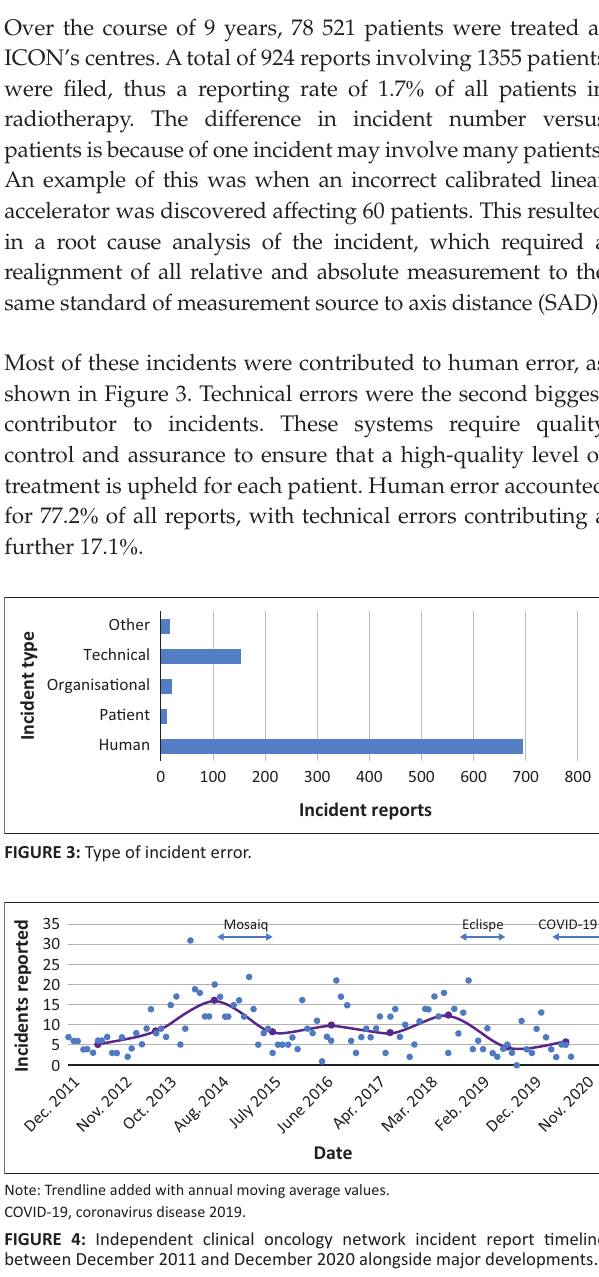
FIGURE 4: Independent clinical oncology network incident report timeline between December 2011 and December 2020 alongside major developments.